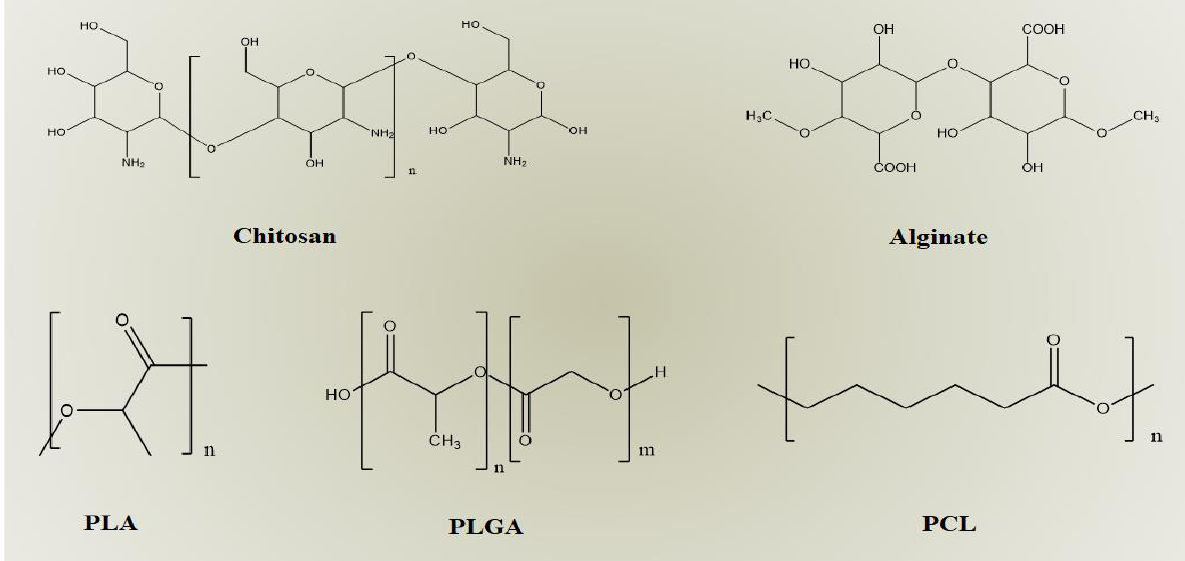
Figure 4. Chemical structures of different polymeric materials used in fabrication of polymeric nanoparticles.